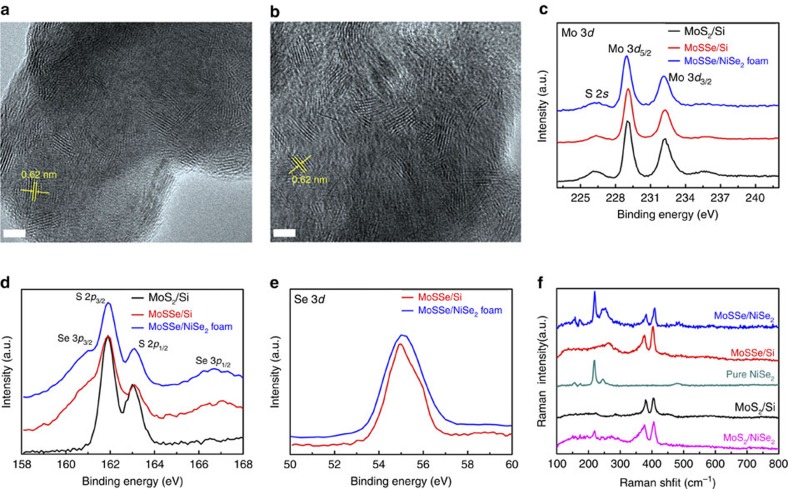
Characterization of the ternary MoS2(1−x)Se2x/NiSe2 foam hybrid catalysts.(a,b) TEM images showing the vertical layer orientation of MoS2(1−x)Se2x particles grown on different regions of porous NiSe2 foam. Scale bar, 5 nm. (c–e) Detailed XPS analysis of the Mo 3d, S 2p and Se 3d spectra in different samples, such as binary MoS2 particles on Si, MoS2(1−x)Se2x particles on Si and MoS2(1−x)Se2x particles on porous NiSe2 foam. (f) Raman spectra measured on different samples.